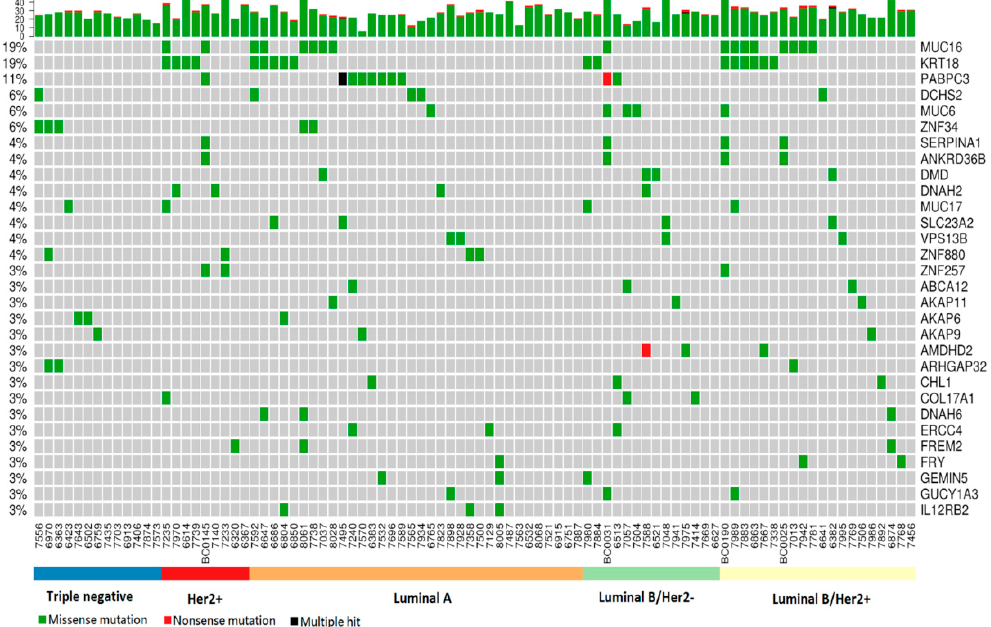
Figure 3. Genes with germline mutations among the 90-patient EOBC cohort. (Top) Each bar represents the number of mutations for a patient; ( Central panel ) Patient mutated genes are labeled with various colors, each representing a particular type of germline mutation. The names of the mutated genes are listed on the right, with the corresponding prevalence shown on the left side.